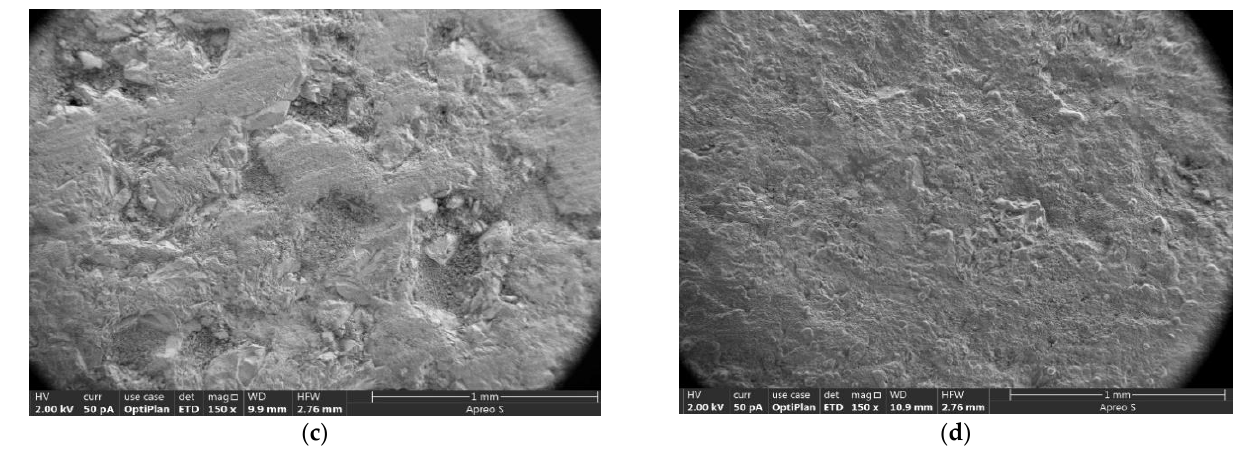
Figure 11. Comparison of pores, pore throats and pore connectivities among the four subcategories of sandstone under SEM (note that the images ( a – d ) correspond to the images a–d in Figure 10, respectively). ( a ) Subcategory I 1 sandstone (Z23). ( b ) Subcategory I 2 sandstone (Z11). ( c ) Subcategory II 1 sandstone (X9). ( d ) Subcategory II 2 sandstone (T13).